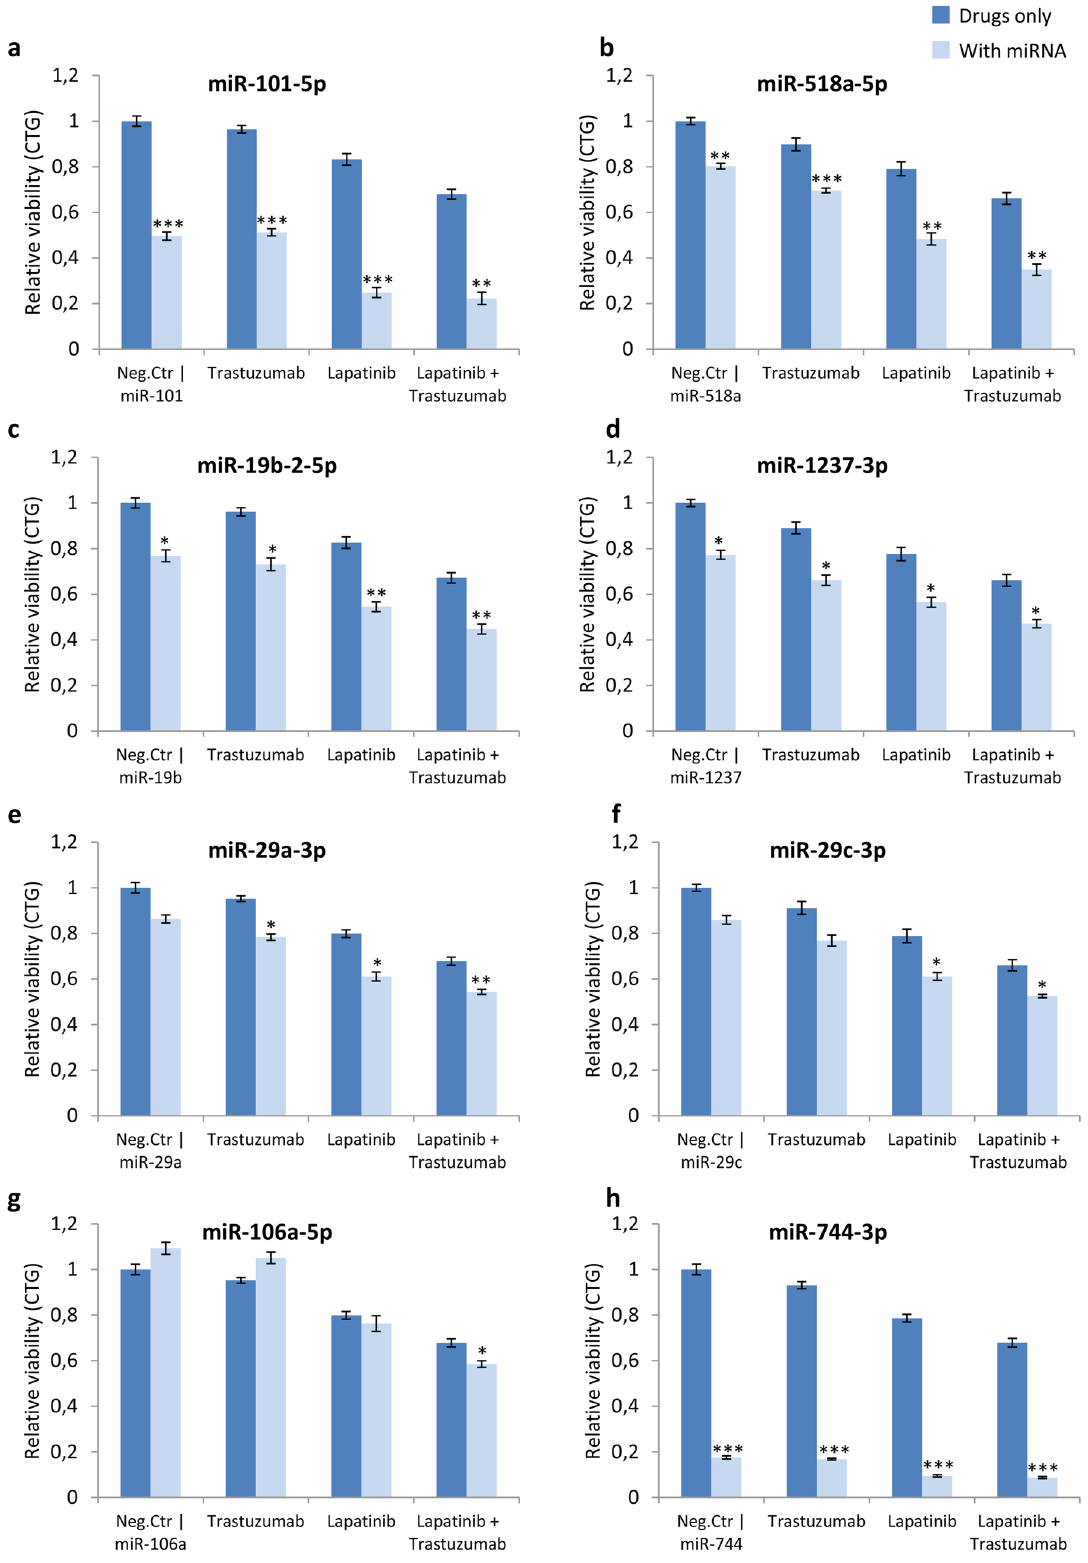
Figure 2. Viability measurements after treatment with sensitizing miRNAs. Viability measurements (by CellTiter-Glo) in cells transfected with indicated miRNA and treated with trastuzumab (10 μg/mL) and lapatinib (100 nM). The figure presents the top eight miRNA mimics that significantly sensitize KPL4 cells to trastuzumab and / or lapatinib. Viability is normalized to the median negative control for each plate. Each experiment is performed with three technical replicates and three biological replicates. Error bars = SEM. * p < 0.05 , ** p < 0.01, *** p < 0.001 (Student’s